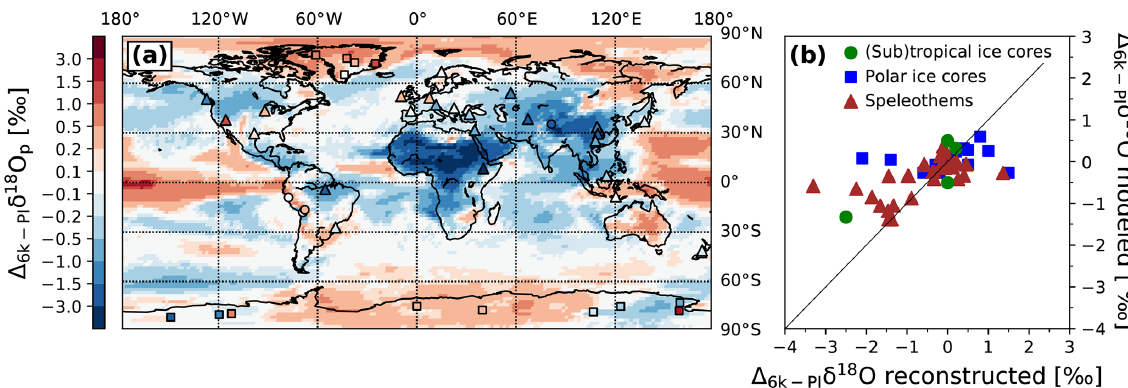
Figure 6. (a) Simulated global pattern of annual mean δ 18 O p changes in precipitation between the mid-Holocene and PI climate as well as a comparison with reconstructed δ 18 O changes in polar (squares) and (sub)tropical (dots) ice cores and in calcite speleothems (triangles). (b) Reconstructed δ 18 O changes from ice cores and speleothems vs. simulated 6k–PI δ 18 O anomalies at the same location. The observed δ 18 O anomalies in polar and (sub)tropical ice core records (blue squares and green dots, respectively) are compared to the simulated 6k–PI δ 18 O p changes in precipitation. The observed (cid:49) 6k − PI δ 18 O in speleothems (brown triangles) are compared to simulated δ 18 O c changes in calcite (see text).